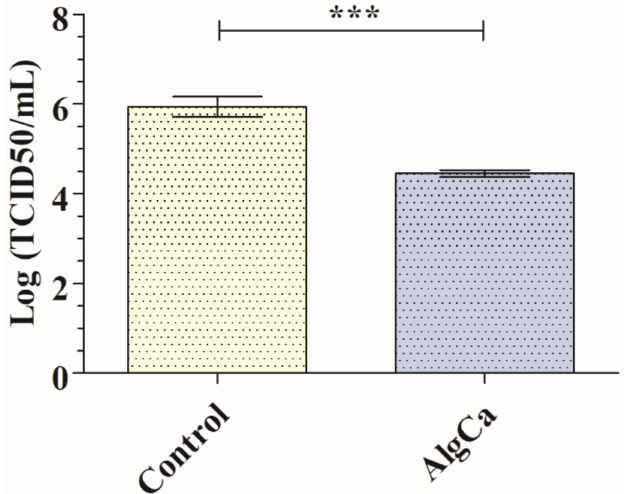
Figure 5. Reduction in infection titers of the SARS-CoV-2 Delta Variant in logarithm of TCID50 per mL (log (TCID50/mL)) and TCID50 per mL. Reduction in infection titers in plaque-forming units per mL (PFU/mL) for control and calcium alginate films (AlgCa) at 30 min of viral contact. *** p > 0.001. Student’s t -test (*** p >